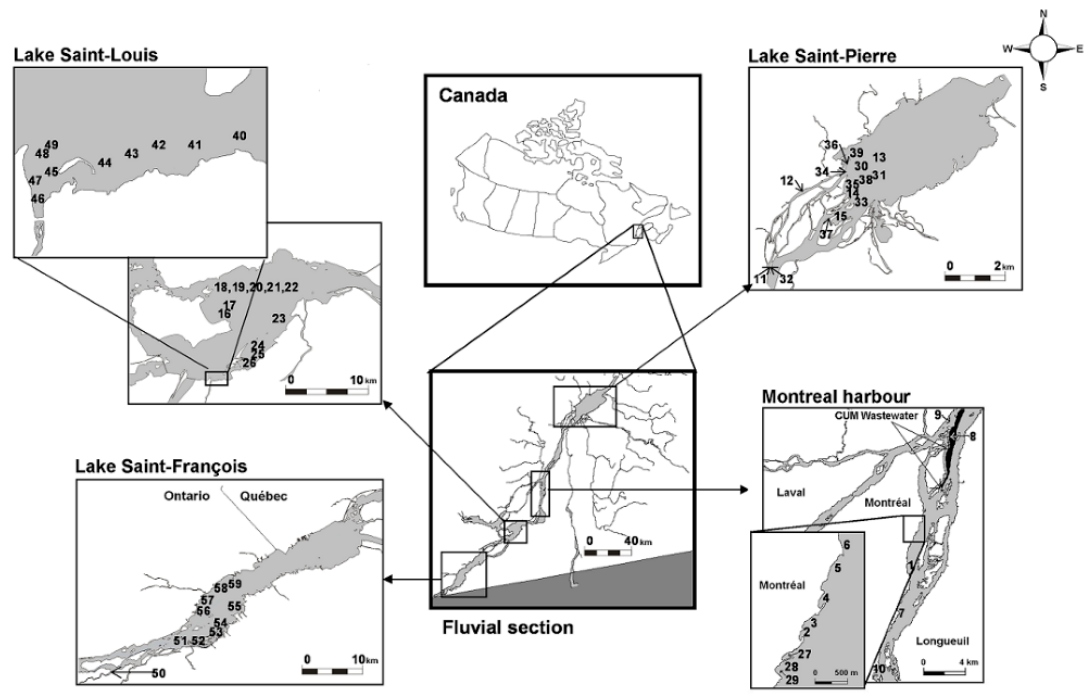
Figure 1. Sites sampled on four habitat zones across the fluvial section of the St. Lawrence River, including the three fluvial lakes and the Montreal Harbour area (from Figure 1, in [23,49] ).